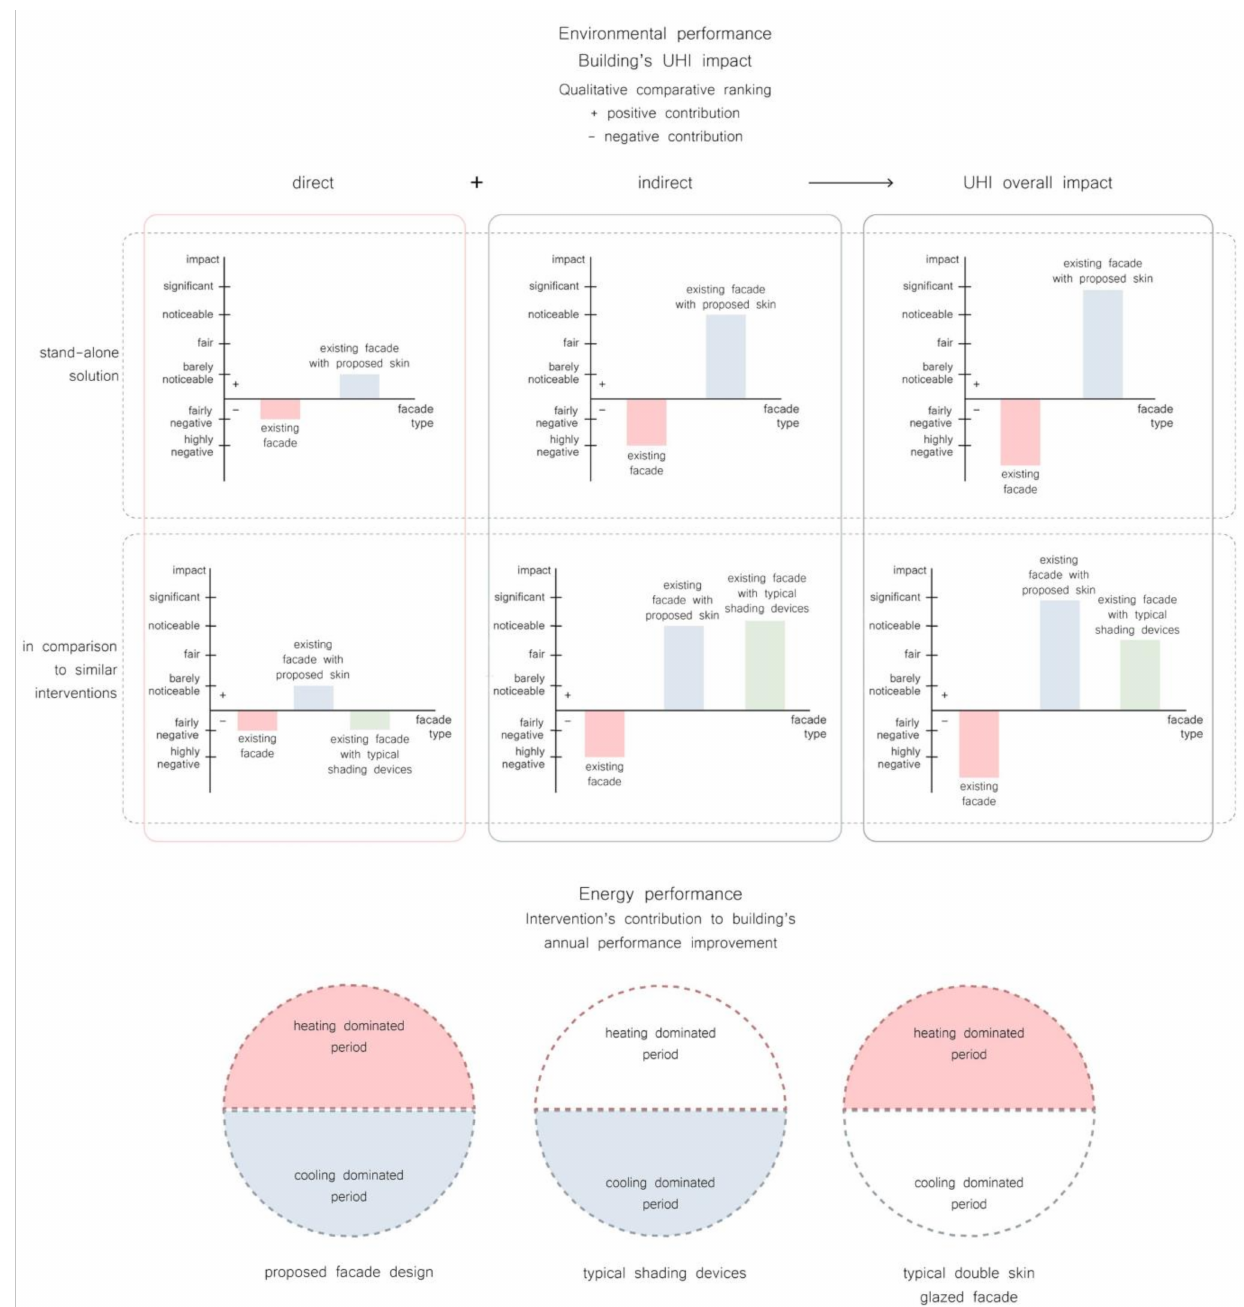
Figure 29. Building’s energy and environmental performance comparative evaluation